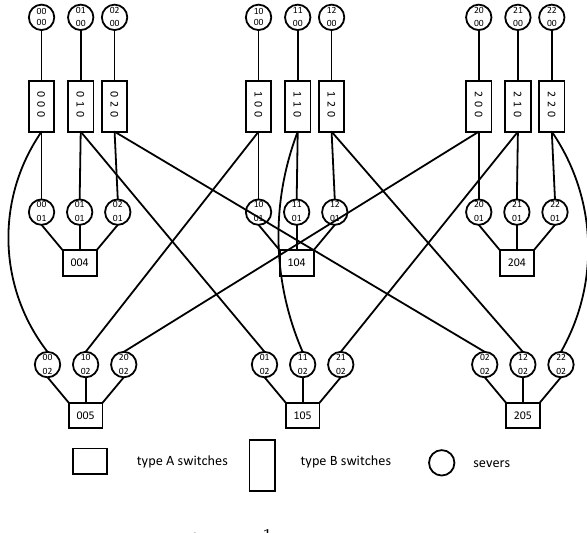
Figure 2. Structure of BCCC 1